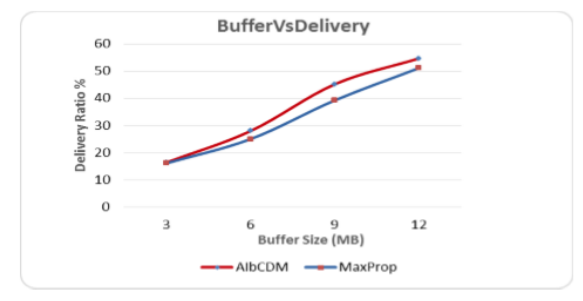
Fig 8 : Buffer Size vs. Delivery